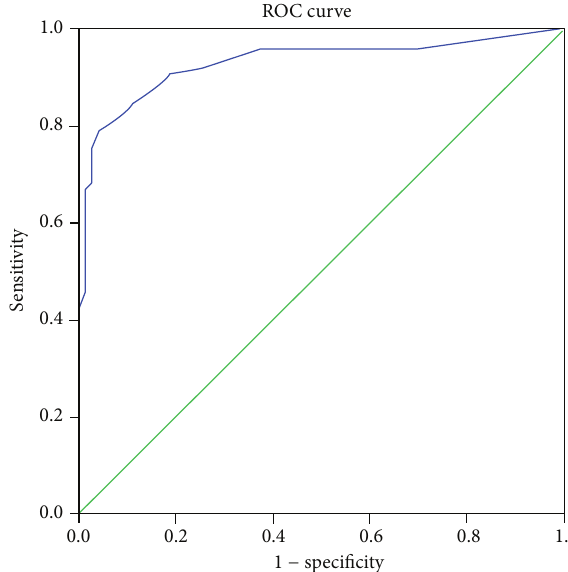
Figure 1: Receiver operating curve. Diagonal segments are pro- duced by